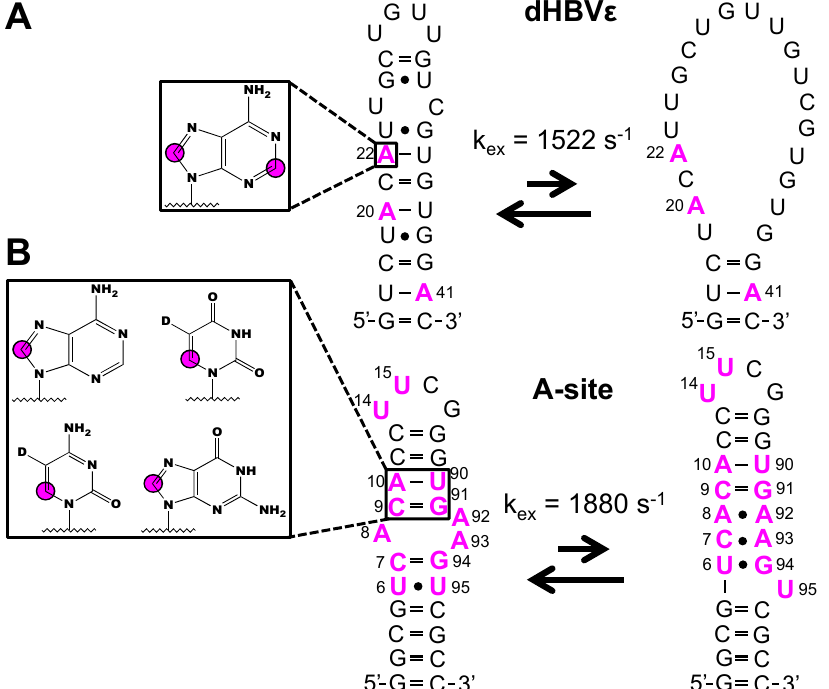
Figure 5. Example of dynamic probing of RNAs made from isotope labeled phosphoramidites. ( A ) Incorporation of [2,8- 13 C 2 ]-adenosine into dHBV ε RNA enabled 13 C CPMG investigation of residues A20, A22, and A41 and the overall kinetic rate of unfolding to be quantified [55]. ( B ) Incorporation of [8- 13 C]-adenosine and –guanosine and [6- 13 C-5- 2 H]-uridine and –cytidine into A-site RNA allowed for the use of 1 H CPMG studies and revealed the overall exchange rate with a minor populated state [61]. Magenta colors indicate labeled residues and magenta circles refer to 13 C atoms.